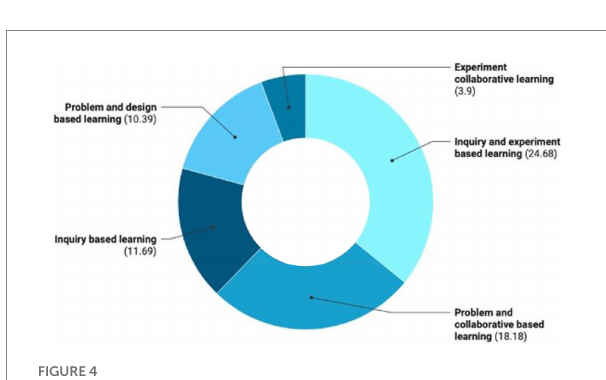
FIGURE 4 Constructivist pedagogical methods deployed in teaching STEM lessons. The percentage is calculated using a total of 77